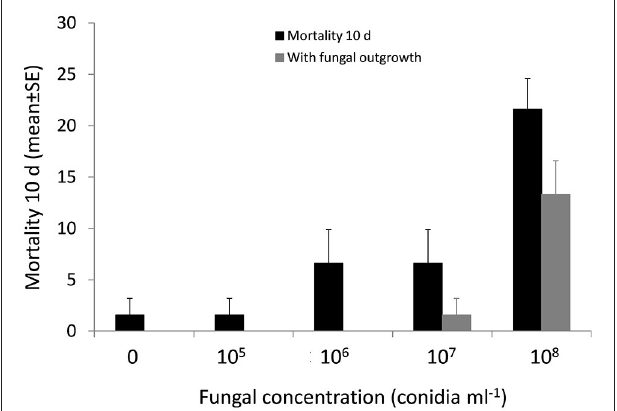
FIGURE 5 | Percentage mortality and fungal outgrowth (mean ± SE) of newly emerged P. conocolor adults after 10 days of exposure to suspensions of conidia at different